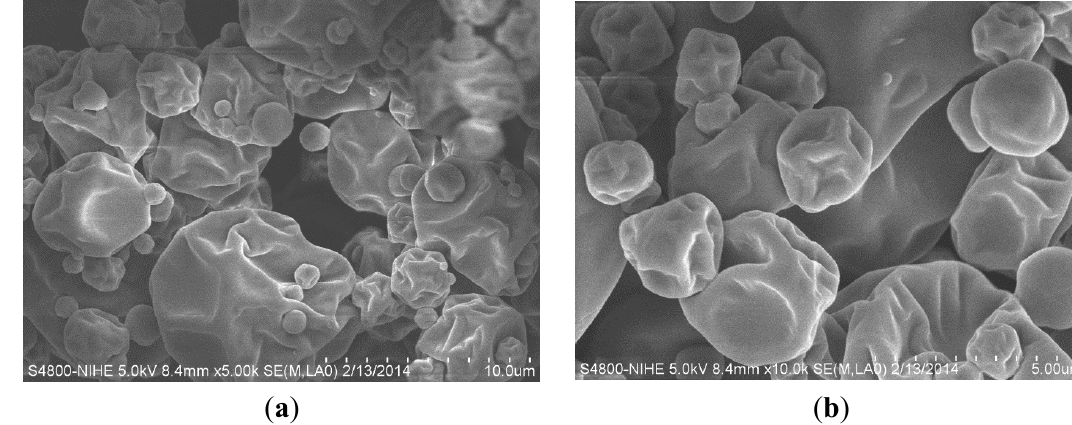
Figure 4. Outer microstructure of the encapsulated powder prepared with the optimal infeed solution formulation, 35% (w/w) maltodextrin and gum arabic (MD/GA, 1:1) with a ratio of aqueous bitter melon extract to MD:GA of 1.5:1 g/g at magnifications of ( a ) ×5000 and ( b )